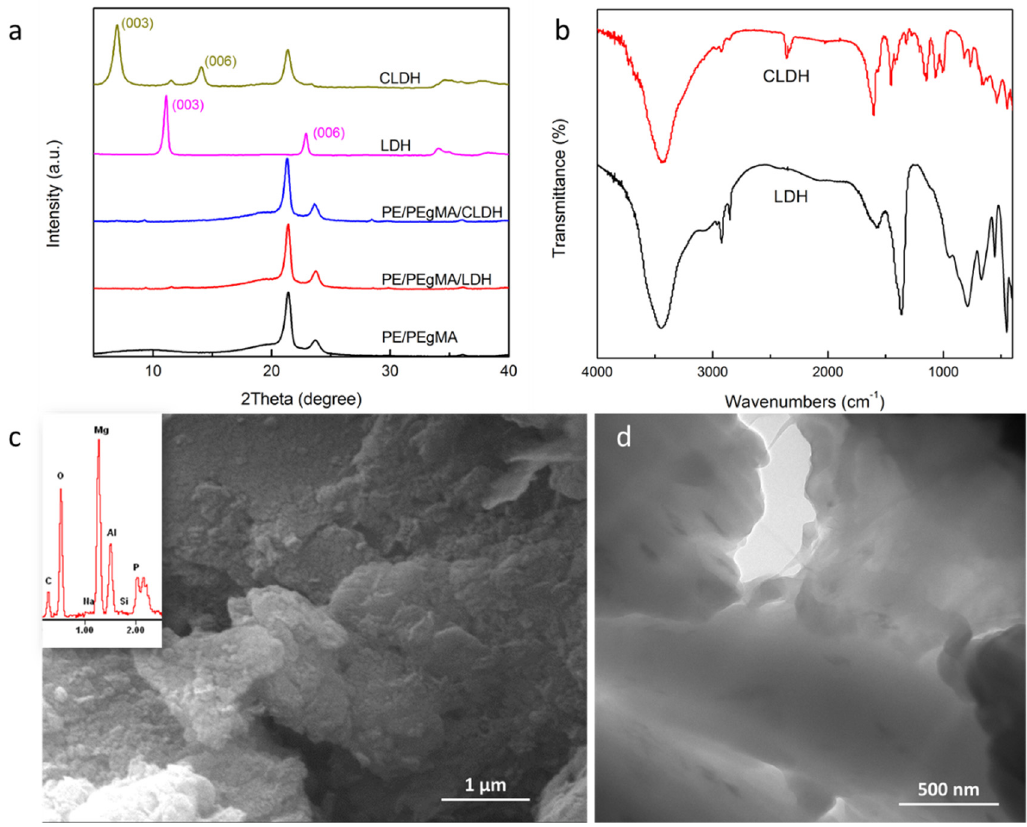
Figure 1. ( a ) XRD patterns of LDH, CLDH, and their composites; ( b ) FTIR spectra of LDH and CLDH; ( c ) SEM micrograph of CLDH inserted with EDS spectrum of CLDH; ( d ) TEM micrograph of PE/PEgMA/CLDH.